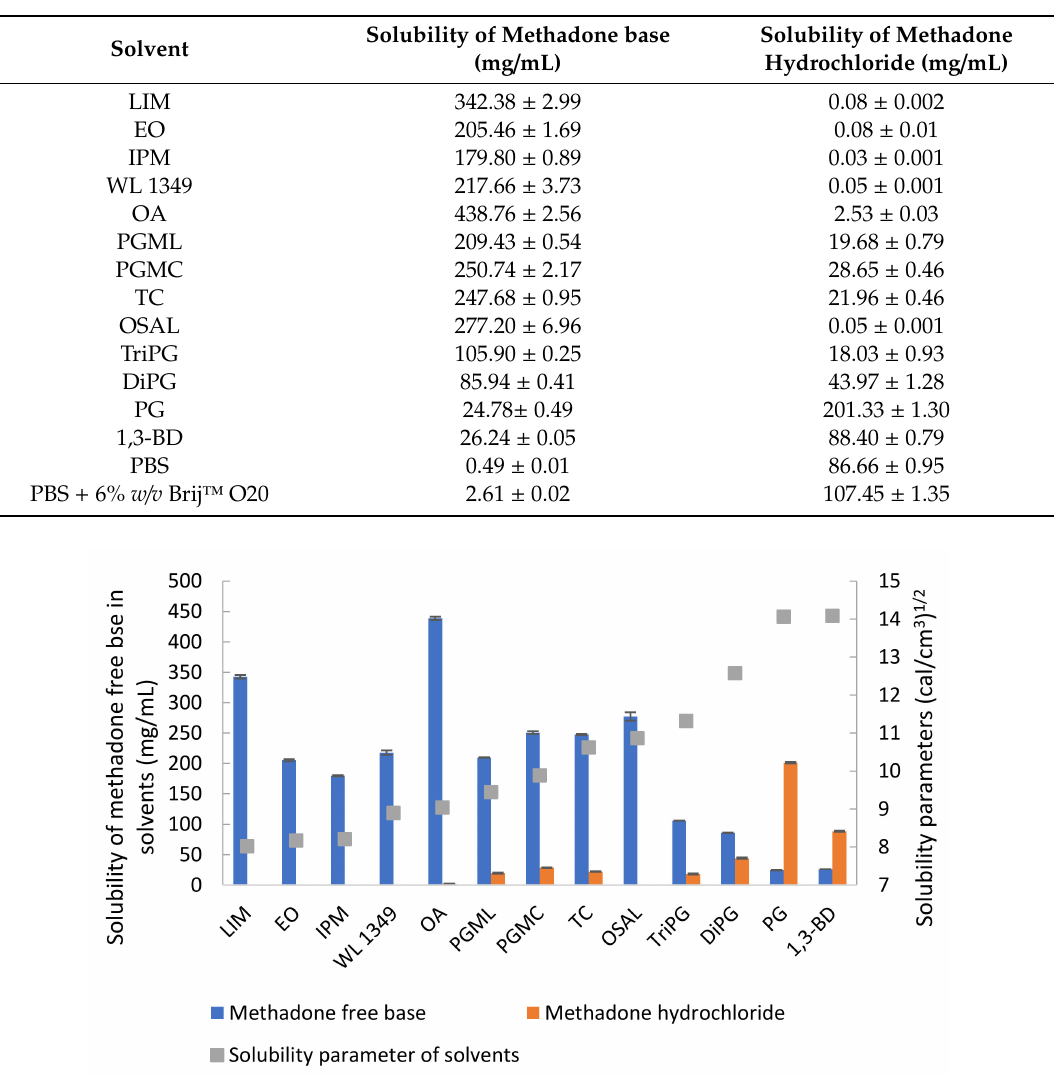
Figure 4. Solubility of methadone free base and methadone hydrochloride in solvents at 32 ± 1 ◦ C and solubility parameters of